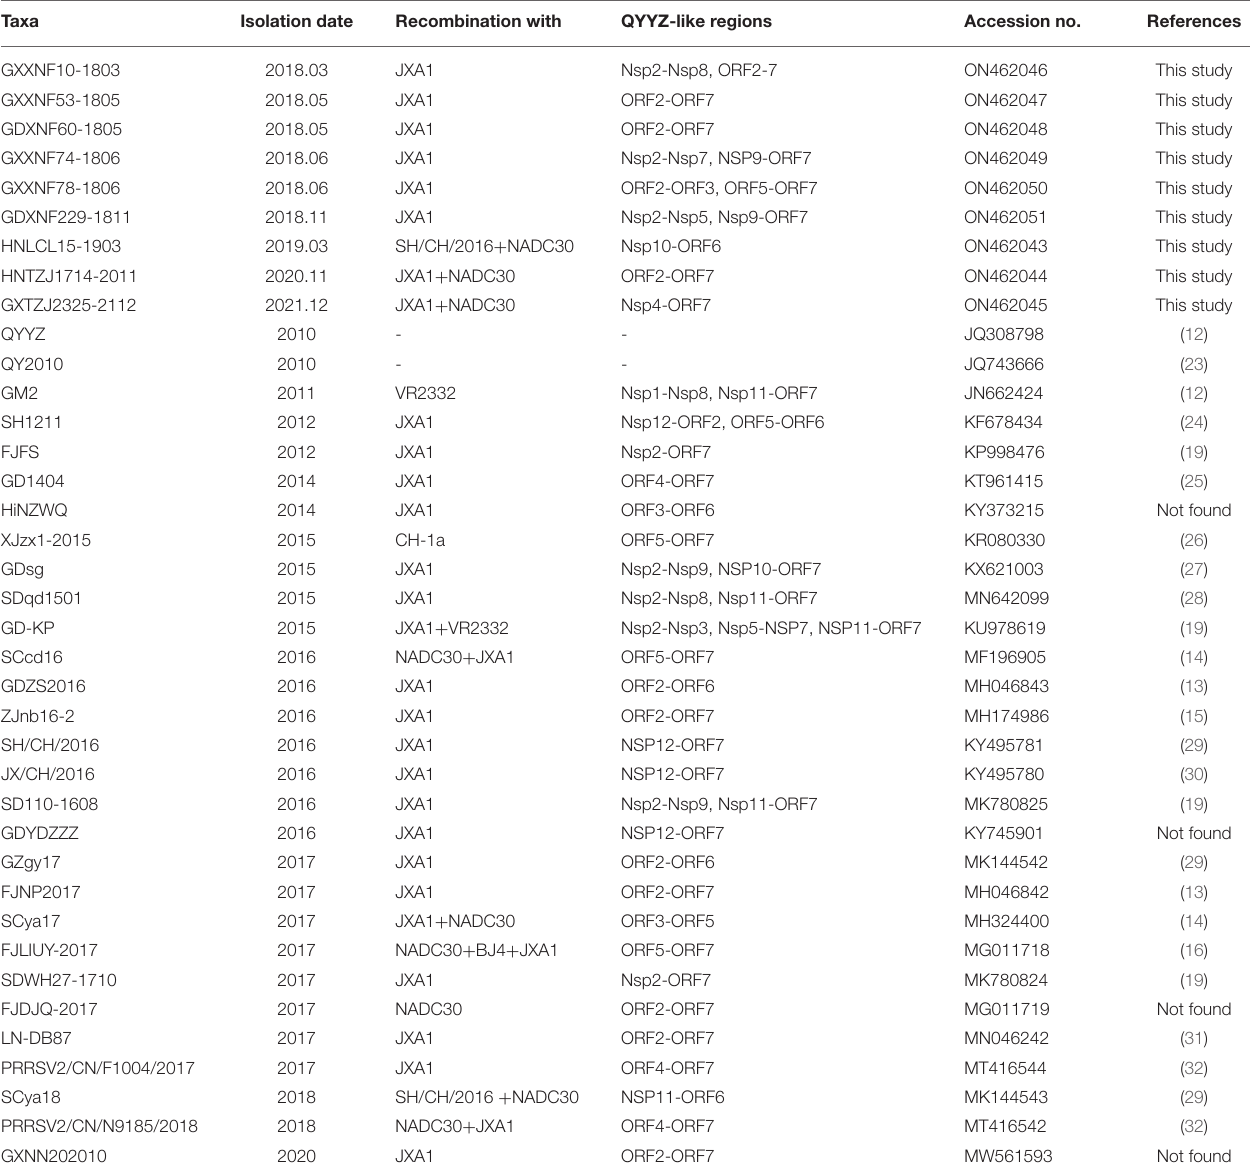
TABLE 3 | Information on the whole genomes of all reported QYYZ-like PRRSV strains in